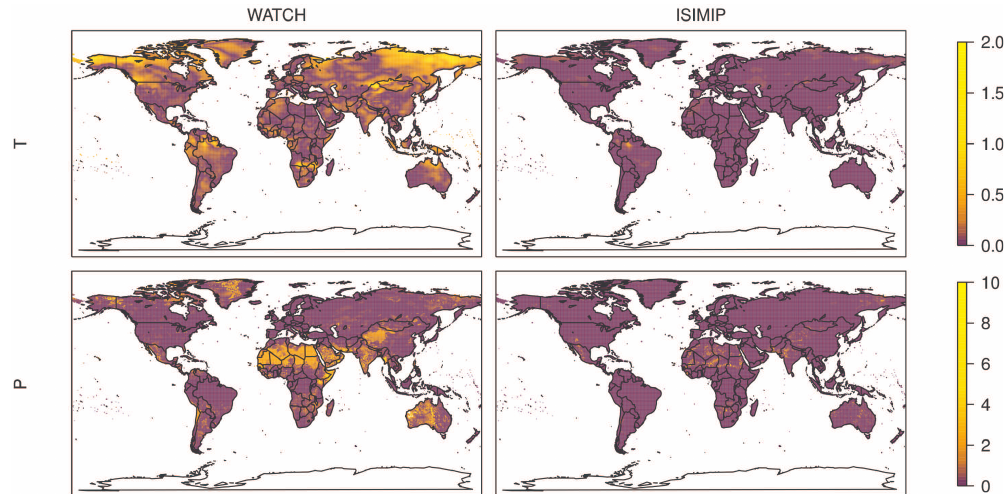
Fig. 9. Absolute differences between the trends in the interpolated GCM April data before and after bias correction. The absolute trend for temperature (in K) is estimated as T 2095 − 2099 − T 1960 − 1964 . In the case of the relative precipitation trend, we consider the logarithm log (P 2095 − 2099 /P 1960 − 1964 ) . Similarly trends in the bias-corrected data are estimated from ˜ T and ˜ P . Values of the absolute differences between the trends in bias-corrected and uncorrected data are truncated at the upper bound of the colourbar, i.e. yellow refers to the denoted or higher values. White areas belong to regions where no information about the trend is available. The results with the quantile mapping applied on the time series themselves (WATCH method) and on the residuals or normalised values (ISIMIP method) are shown for temperature and precipitation (cf. Table 2 for main algorithmic differences). We consider the end of the 21st century (mean 2095–2099) in comparison to the beginning of the reference period (mean 1960–1964) to define the